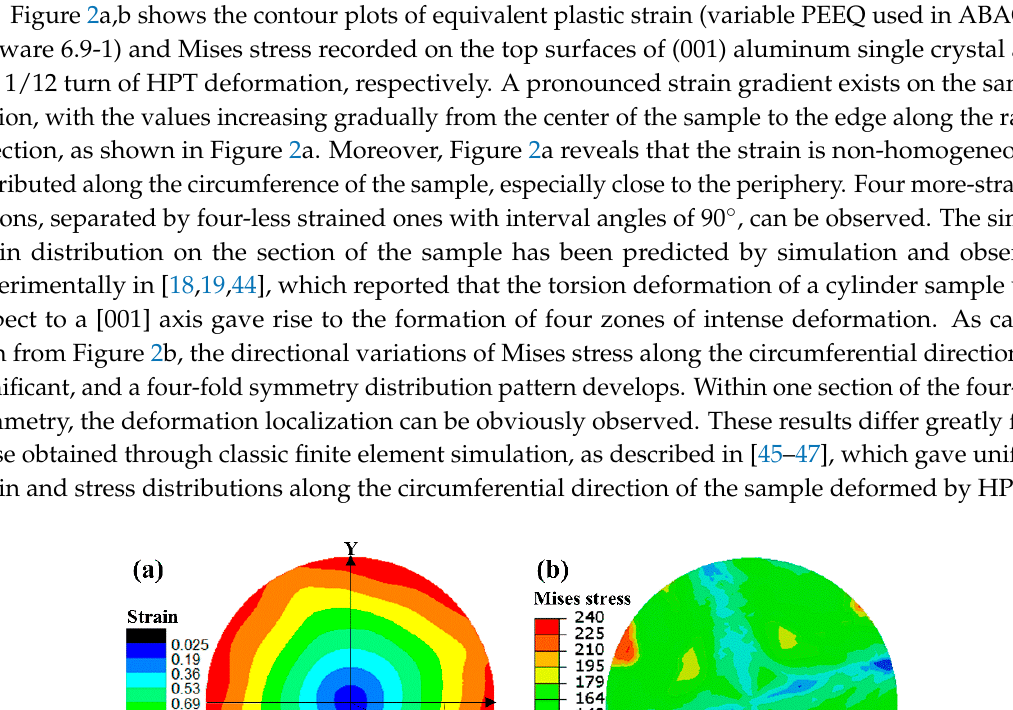
(Figure 3a) for position (cid:2030) = −30° , gradually approaches the ideal C component as the sample position changes from (cid:2030) = −15° , 0° to (cid:2030) = 18° (Figure 3b–d), then rotates gradually away from